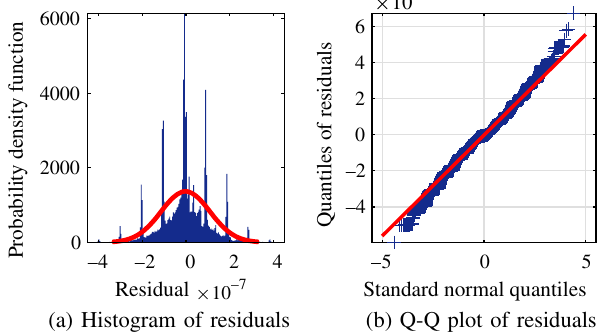
FIG. 4. Probability plots of residuals without beam. In red, a fitted normal distribution is shown.